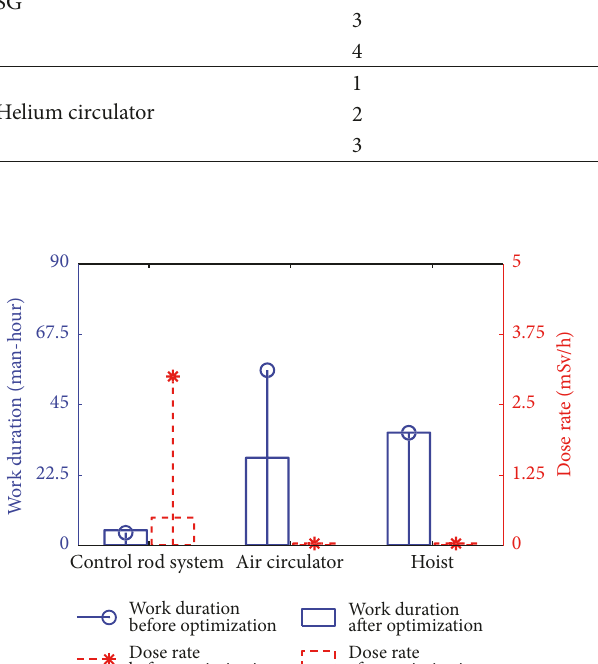
Figure 9: Dose rates and work durations of the control rod system, air circulator, and